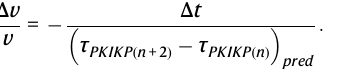
waveforms are bandpass fi ltered in the period band of 7 – 13s. C Linear stack of individual waveforms. E The spectrograms of stacked waveforms before fi ltering show the frequencycontent variation asa function of time. ( B , D , F ) Similar to (A), (C), and (E) but for the PKIKP4